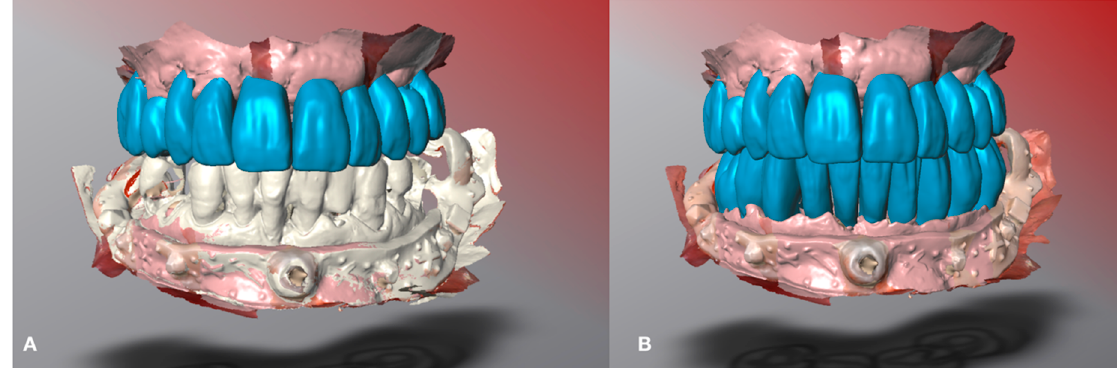
Figure 9. Restoration design. ( A ) Maxillary computer-aided restoration designed. ( B ) Design of the mandibular computer- aided restoration.